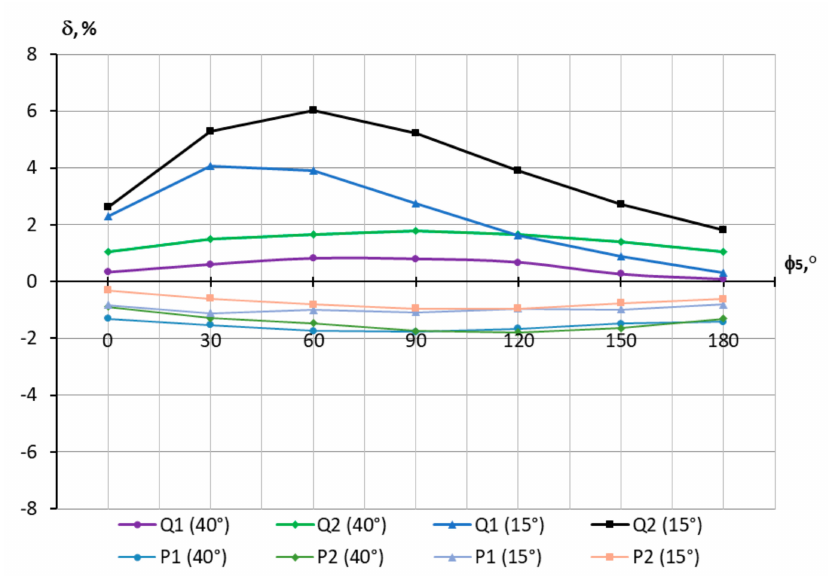
Figure 5. The dependences of the relative metering error for active and reactive power on the phase shift angle at the 5th harmonic.